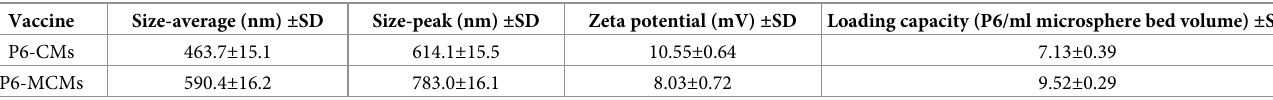
The subpopulations of lymphocytes separated from splenocytes were characterized with a FACSCalibur flow cytometer. Fig 6A shows the alterations in CD3 + , CD3 + CD4 + and Table 2. Characteristics of the loaded microspheres (mean ± SD, n =